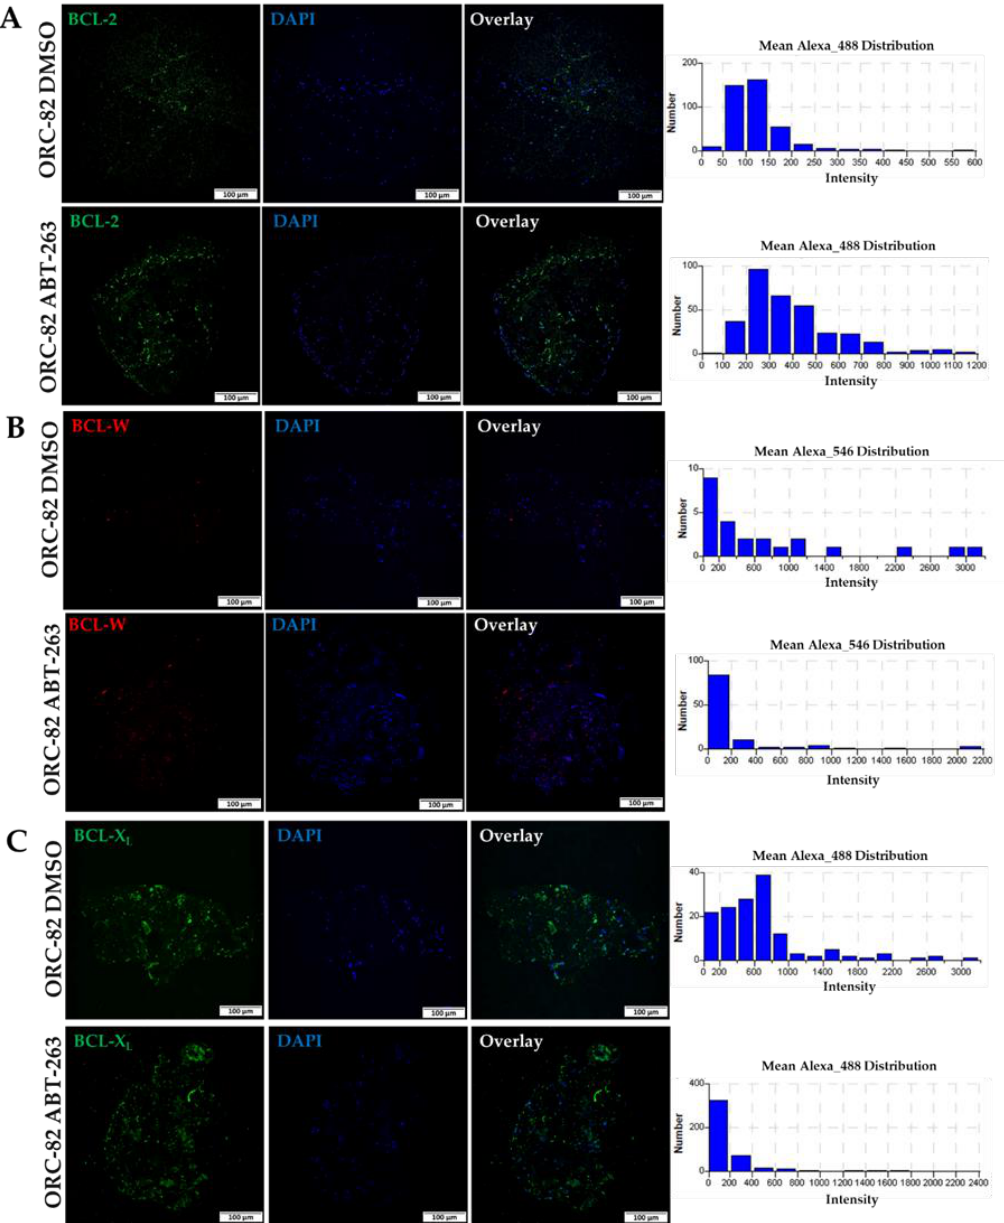
Figure 5. Immunofluorescence staining of antiapoptotic molecules in organoid OCR-82 after ABT-263 treatment. Panel ( A ) shows expression of BCL-2 (green); panel ( B ) shows expression of BCL-W (red); and panel ( C ) shows expression of BCL-X L (green) in DMSO control treatment (ORC-82-DMSO) and after ABT-263 treatment (ORC-82-ABT-263). Nuclei (blue) were stained by DAPI; quantification of immunofluorescence signals are represented in bar diagrams; and all images are at 10× magnification (scale bar: 100 µm).